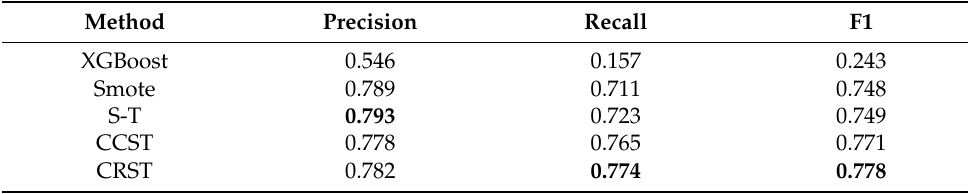
Table 2. Experimental results for the XGBoost, Smote, S-T, CCST and CRST methods. Method Precision